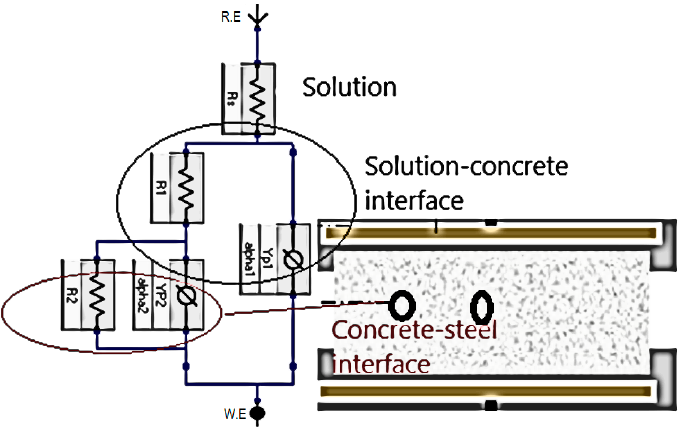
Figure 4. Equivalent circuit corresponding to the different interfaces.